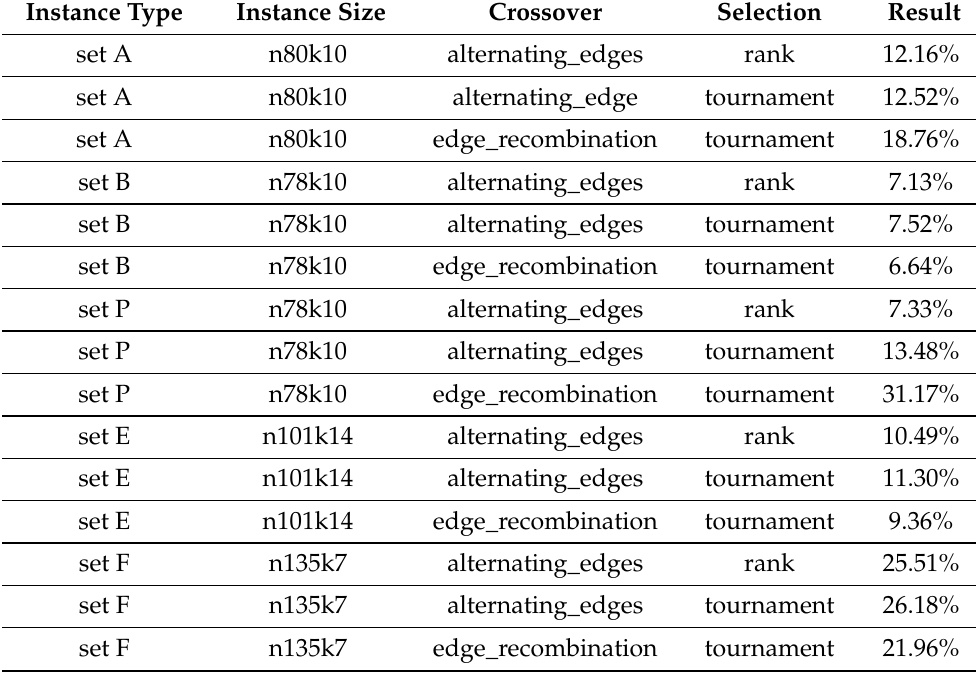
Table 9. Best combinations, long, large examples experiment–results for all combinations, from all